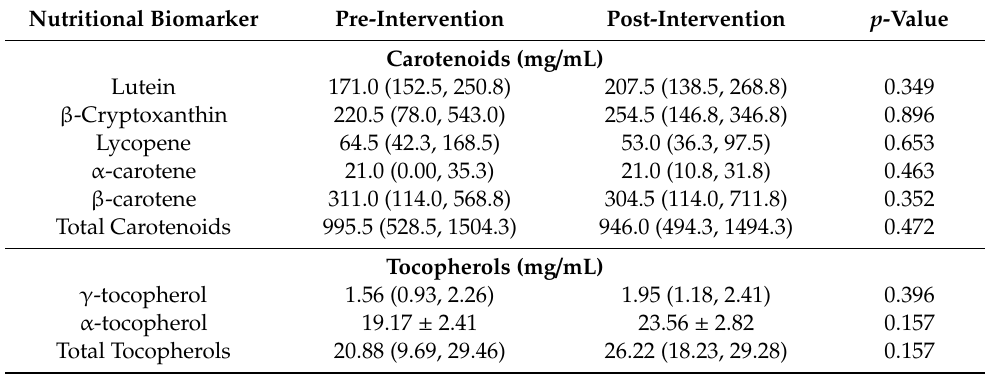
Table 4. Change in plasma carotenoids and tocopherols in obese asthmatic children following a 10-week dietary intervention.